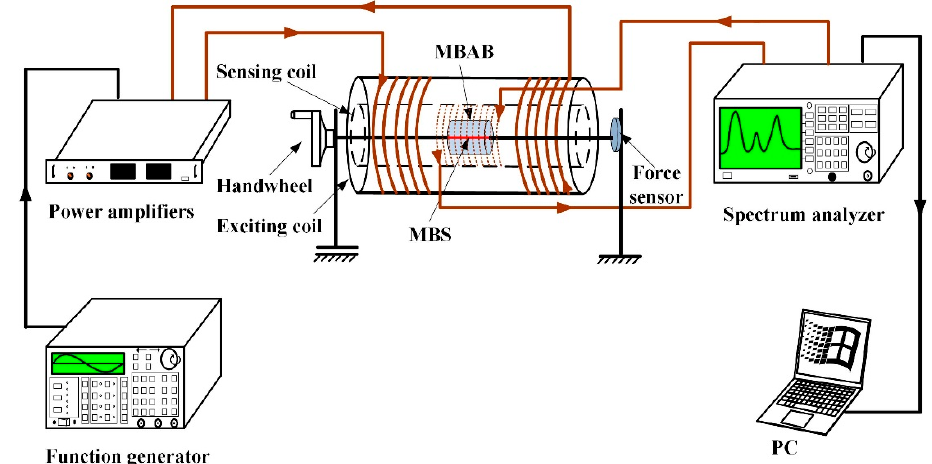
Figure 3. Experimental platform and devices. The EMBAB is fixed in the middle of the platform by two stainless steel bars surrounding the sensing coil (light brown dotted line) and the exciting coil (thick brown line). The external force was kept at 100 N in each daily test.